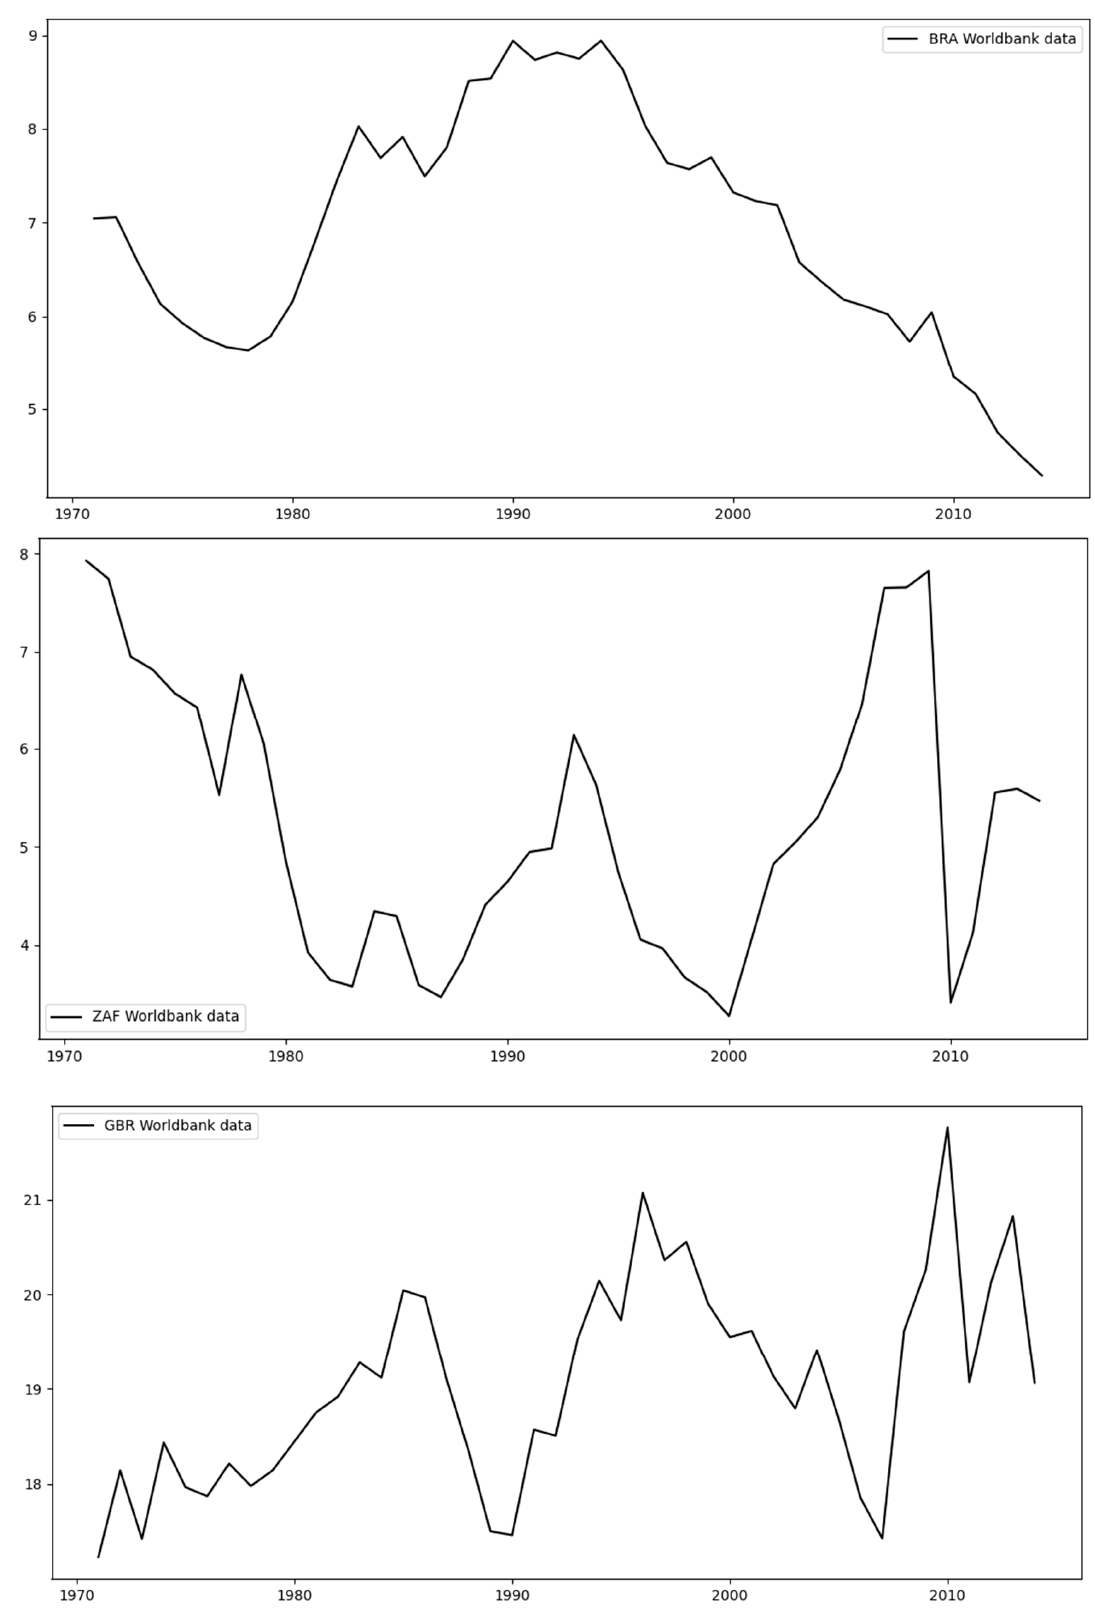
Figure 4. Original data for Brazil (BRA), South Africa (ZAF), and Great Britain (GBR) covering the period between 1971–2014. The vertical axis shows the CO 2 emissions from buildings expressed as a percentage of fuel combustion (dataset provided by the World Bank).